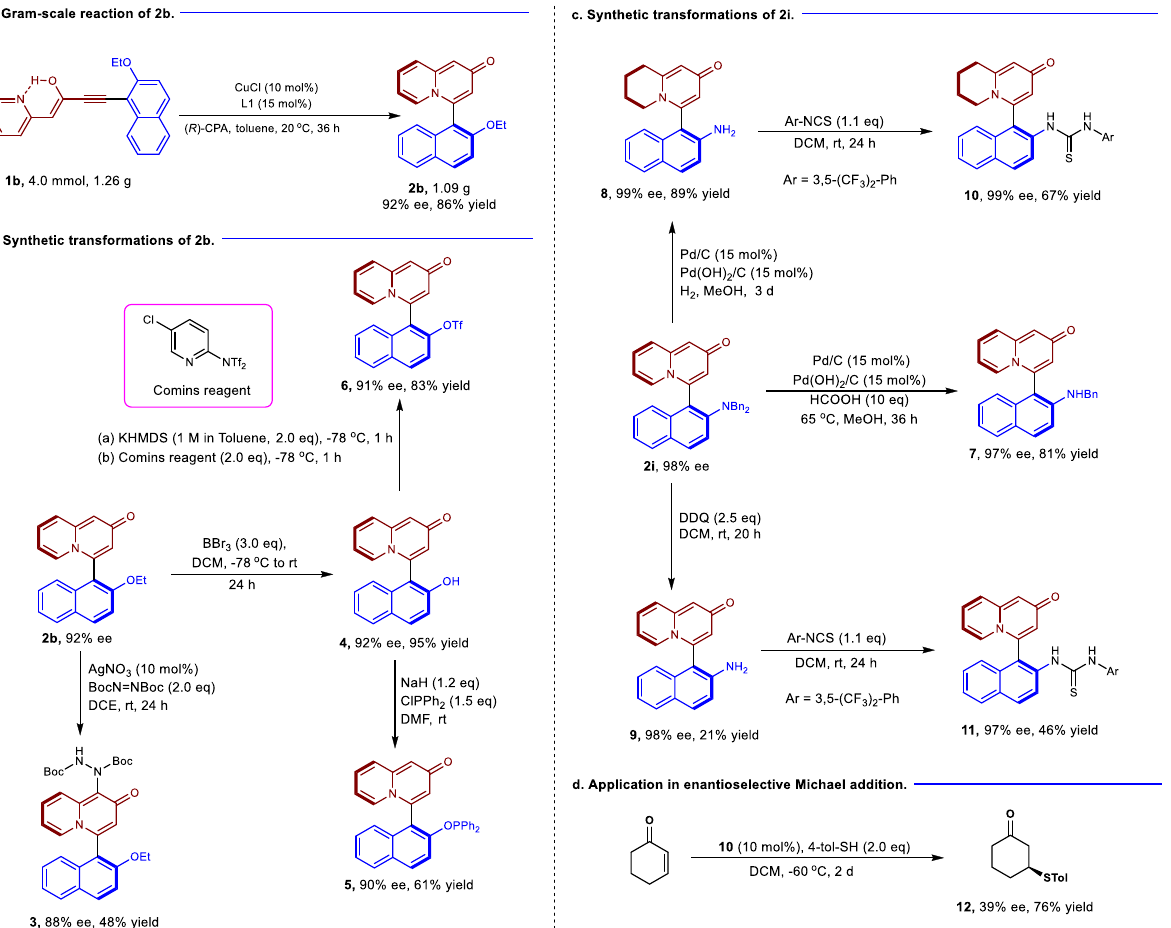
Fig. 3 Large-scale experiments and synthetic applications. a Gram-scale reaction of 2b . b Synthetic transformations of 2b . c Synthetic transformations of 2i . d Enantioselective Michael addition using compound 10 as the